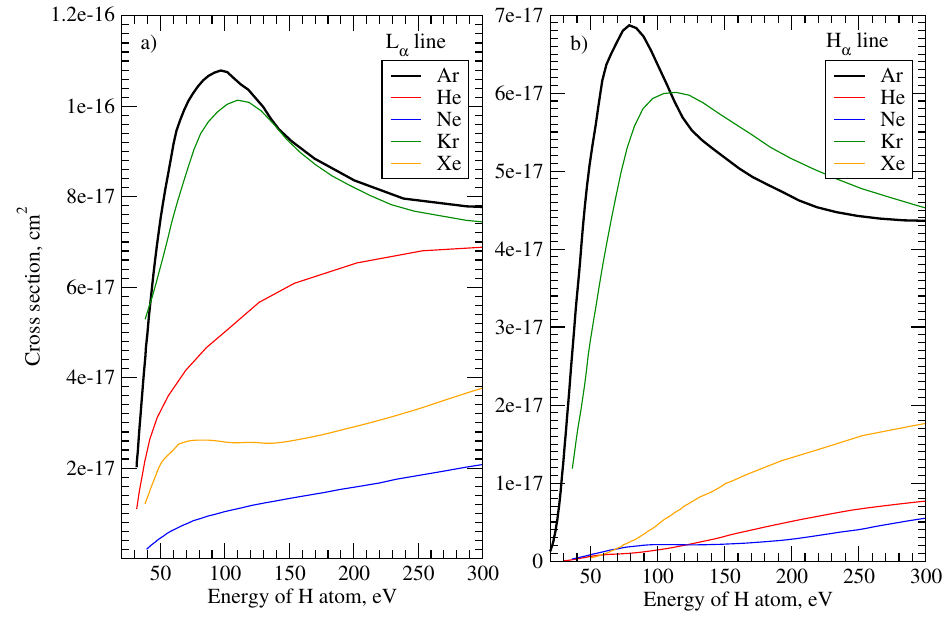
Figure 2. Experimental data on the emission cross-section of the Lyman- α ( a ) and Balmer- α lines ( b ) excited by collision of H atoms with noble gases. Data are digitalized from